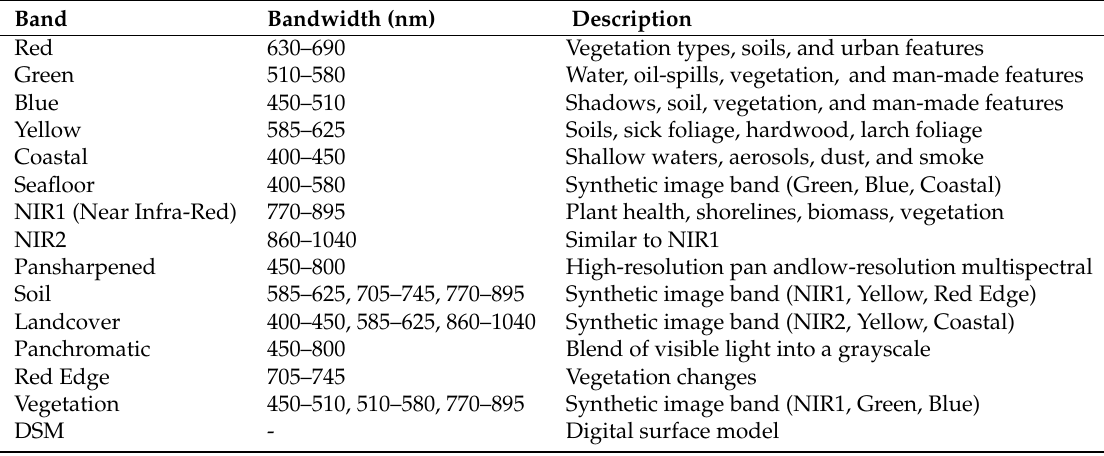
Table 1. Spectral bands used in the multispectral orthography